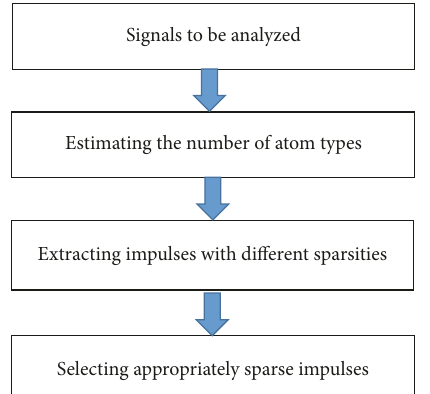
Figure 2: Fault detection procedure based on appropriately sparse impulse extraction.